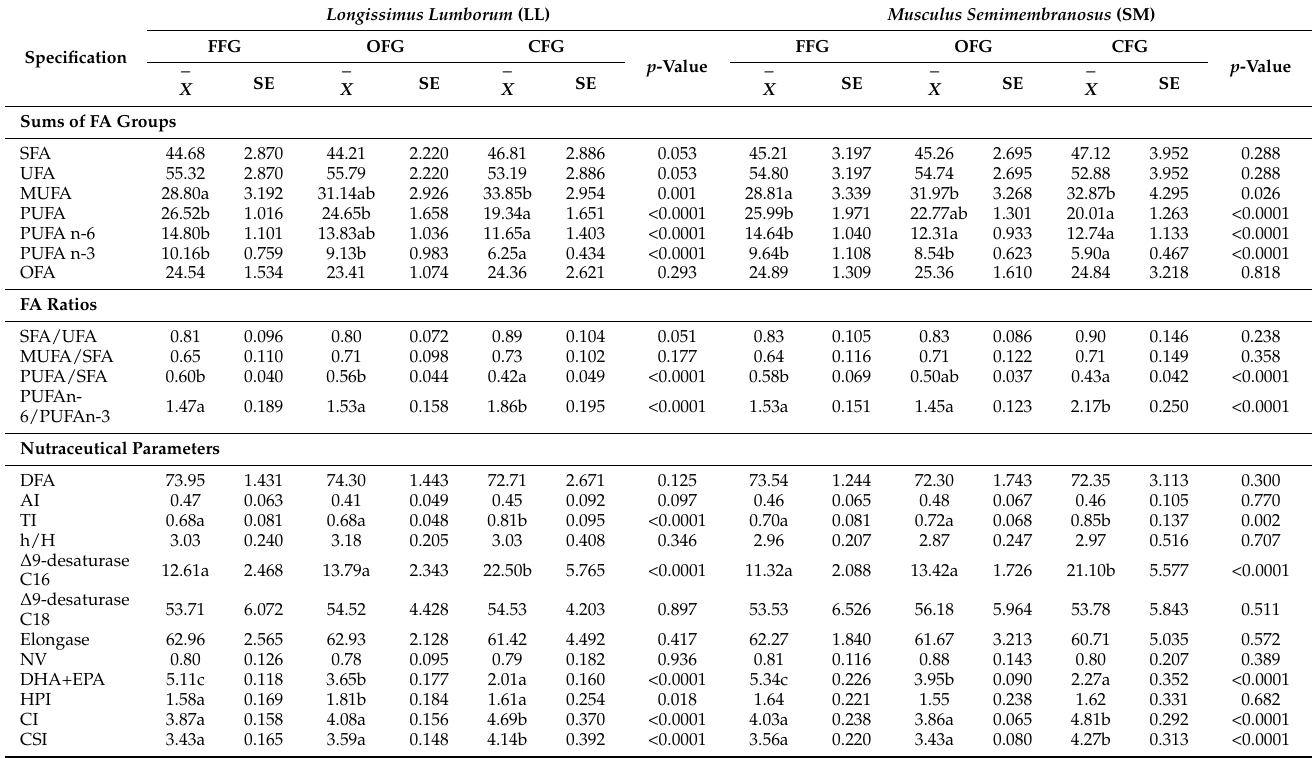
Table 4. Sum of FA groups (g/100 g FA), proportions of fatty acids, and nutraceutical indices of lipids in red deer meat sampled from the three feeding